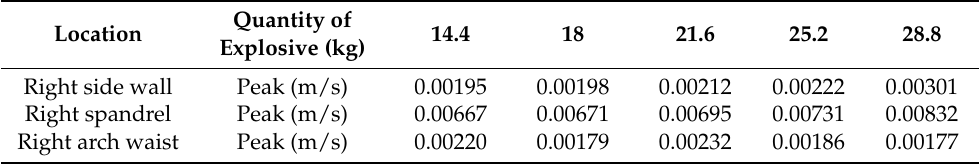
Figure 12. Steel fiber concrete tunnel right arch waist vibration speed curve. Table 8. Peak particle velocity and position of vibration velocity with the same explosive